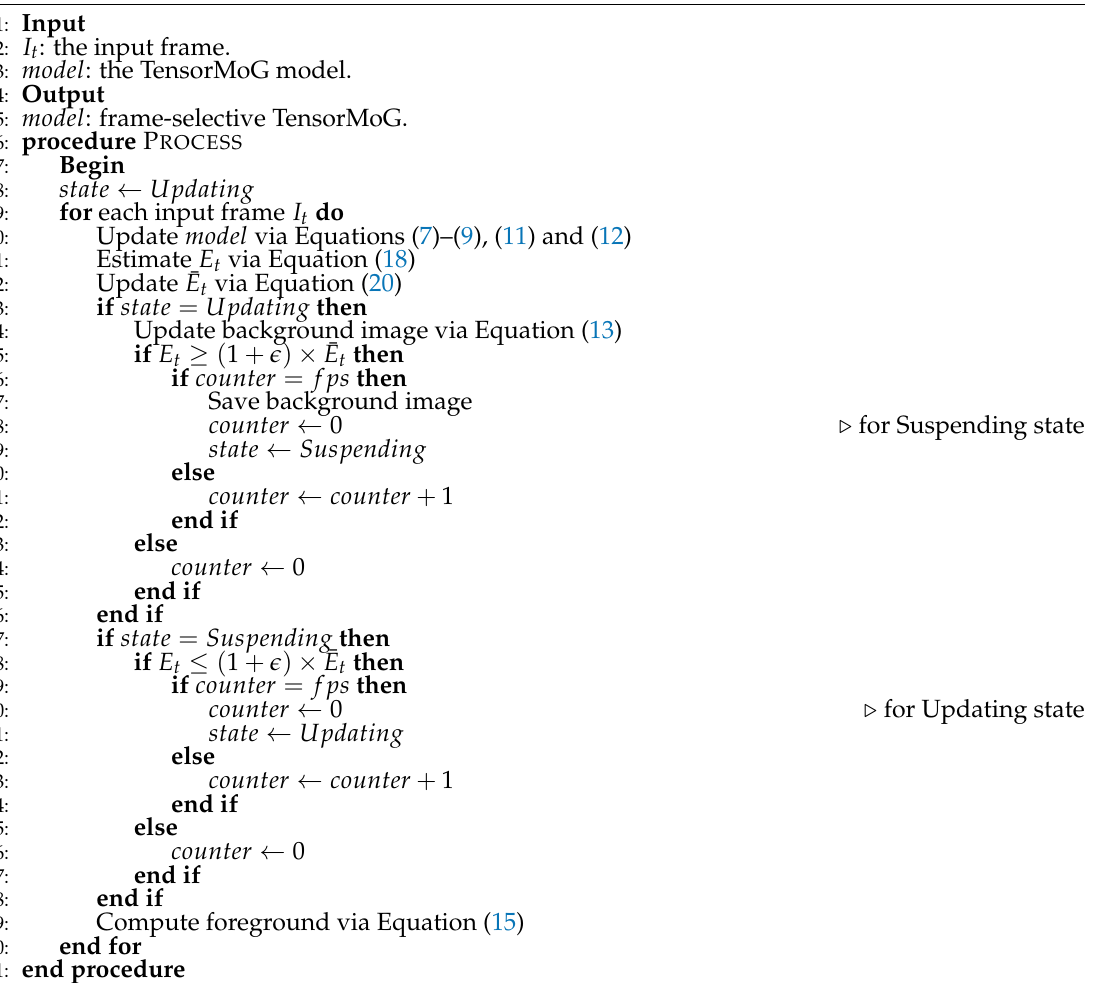
Algorithm 1 Background modelling with frame-selective